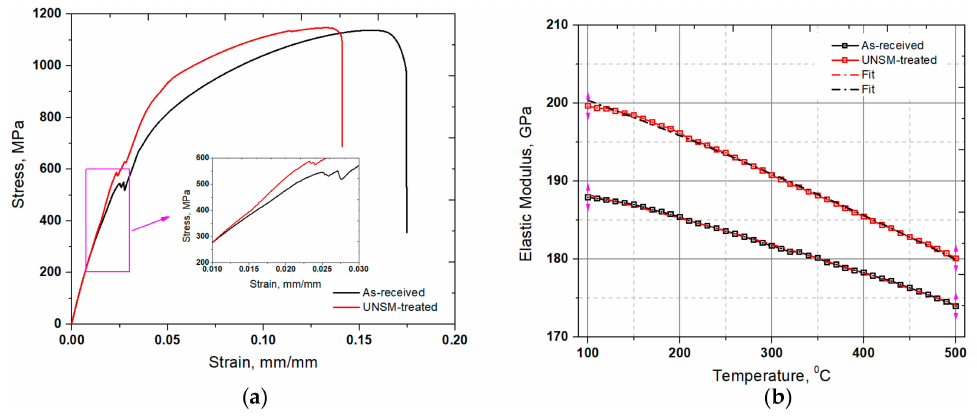
Figure 3. Stress-strain curve ( a ) and elastic modulus ( b ) change of the as-received and UNSM-treated specimens.